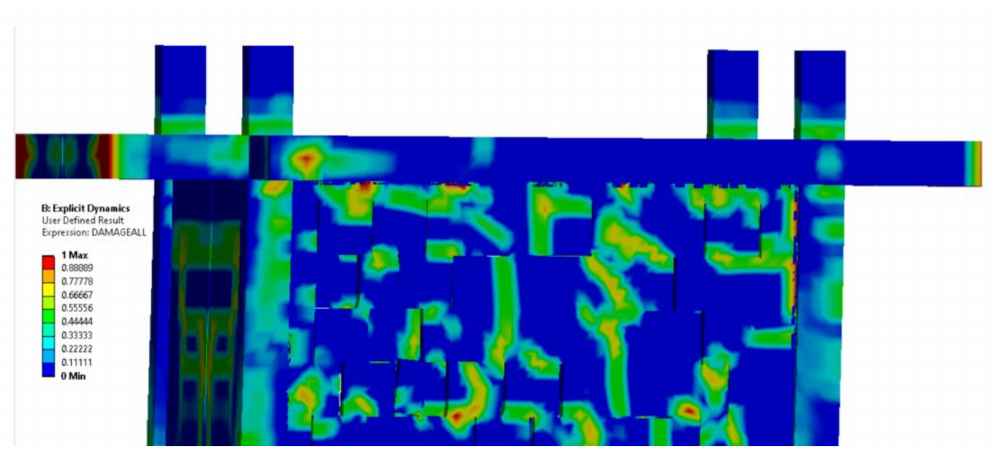
Figure 8. Damage accumulation in model 3DOW at the end of PHASE 2 (upper